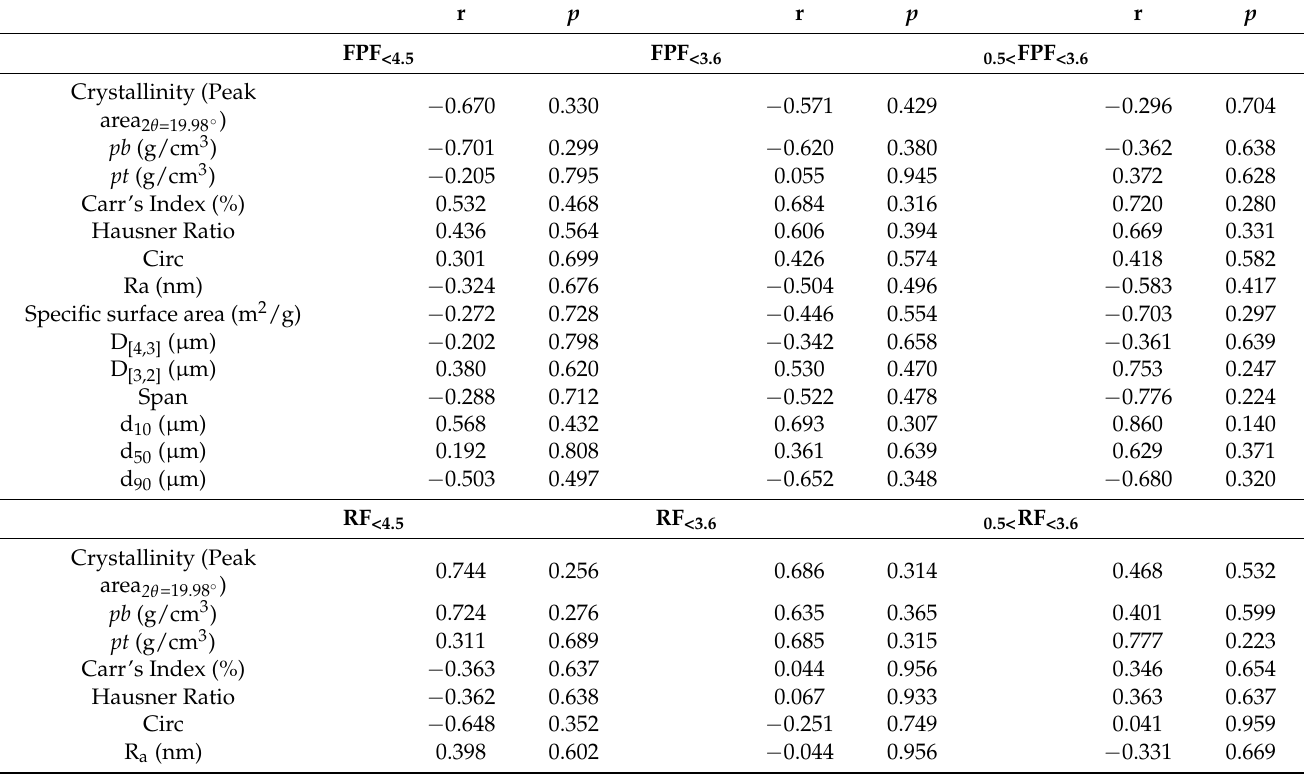
Table 4. Pearson correlation of fine particle and respirable fractions of chitosan nanoparticles with physicochemical characteristics of lactose-PEG microparticles L1, L3, L4 and